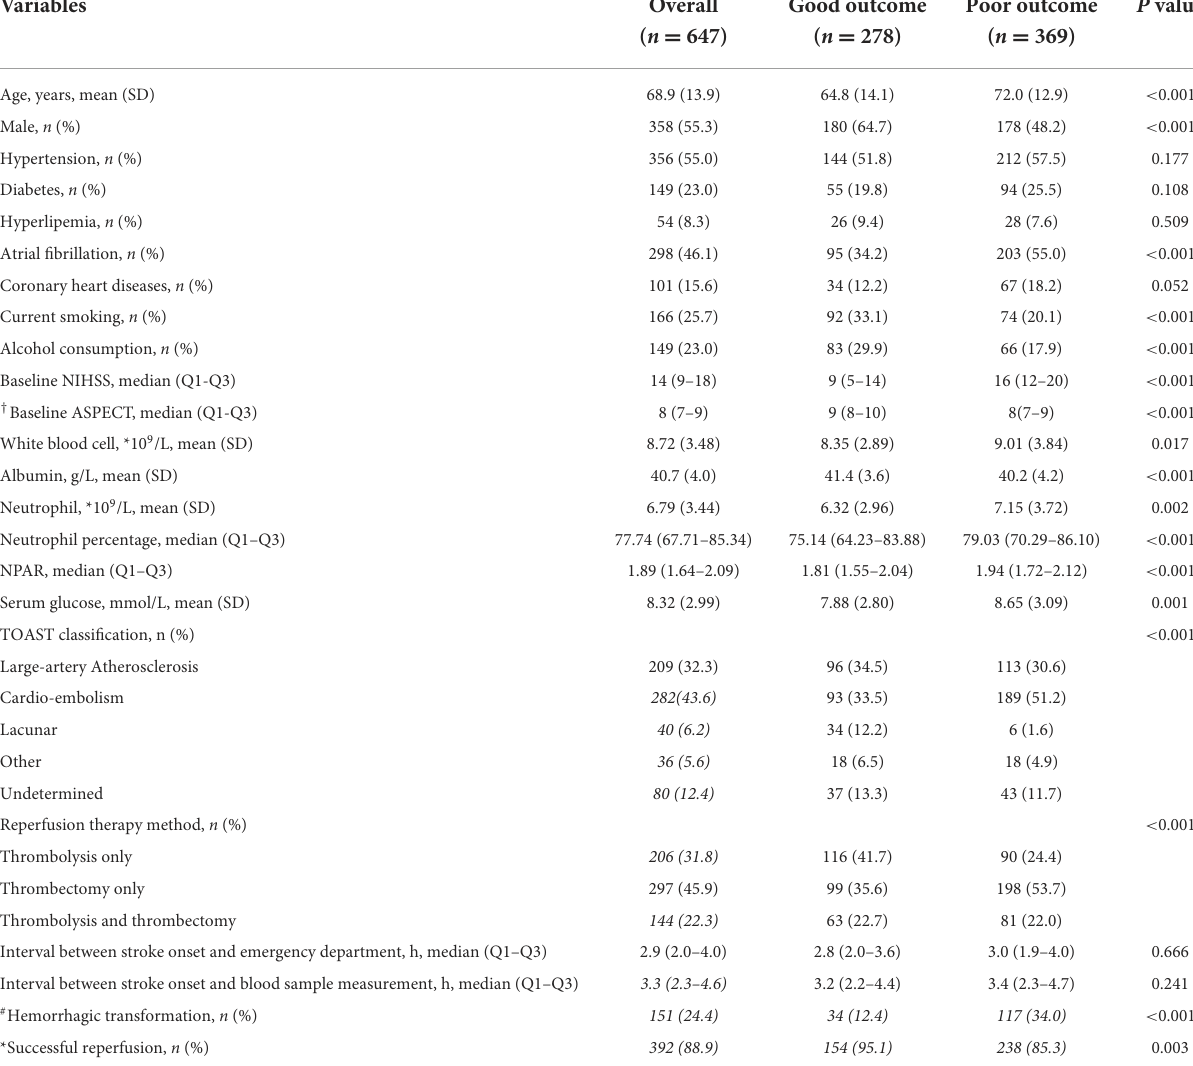
TABLE 1 Patient characteristics stratified by 3-month functional